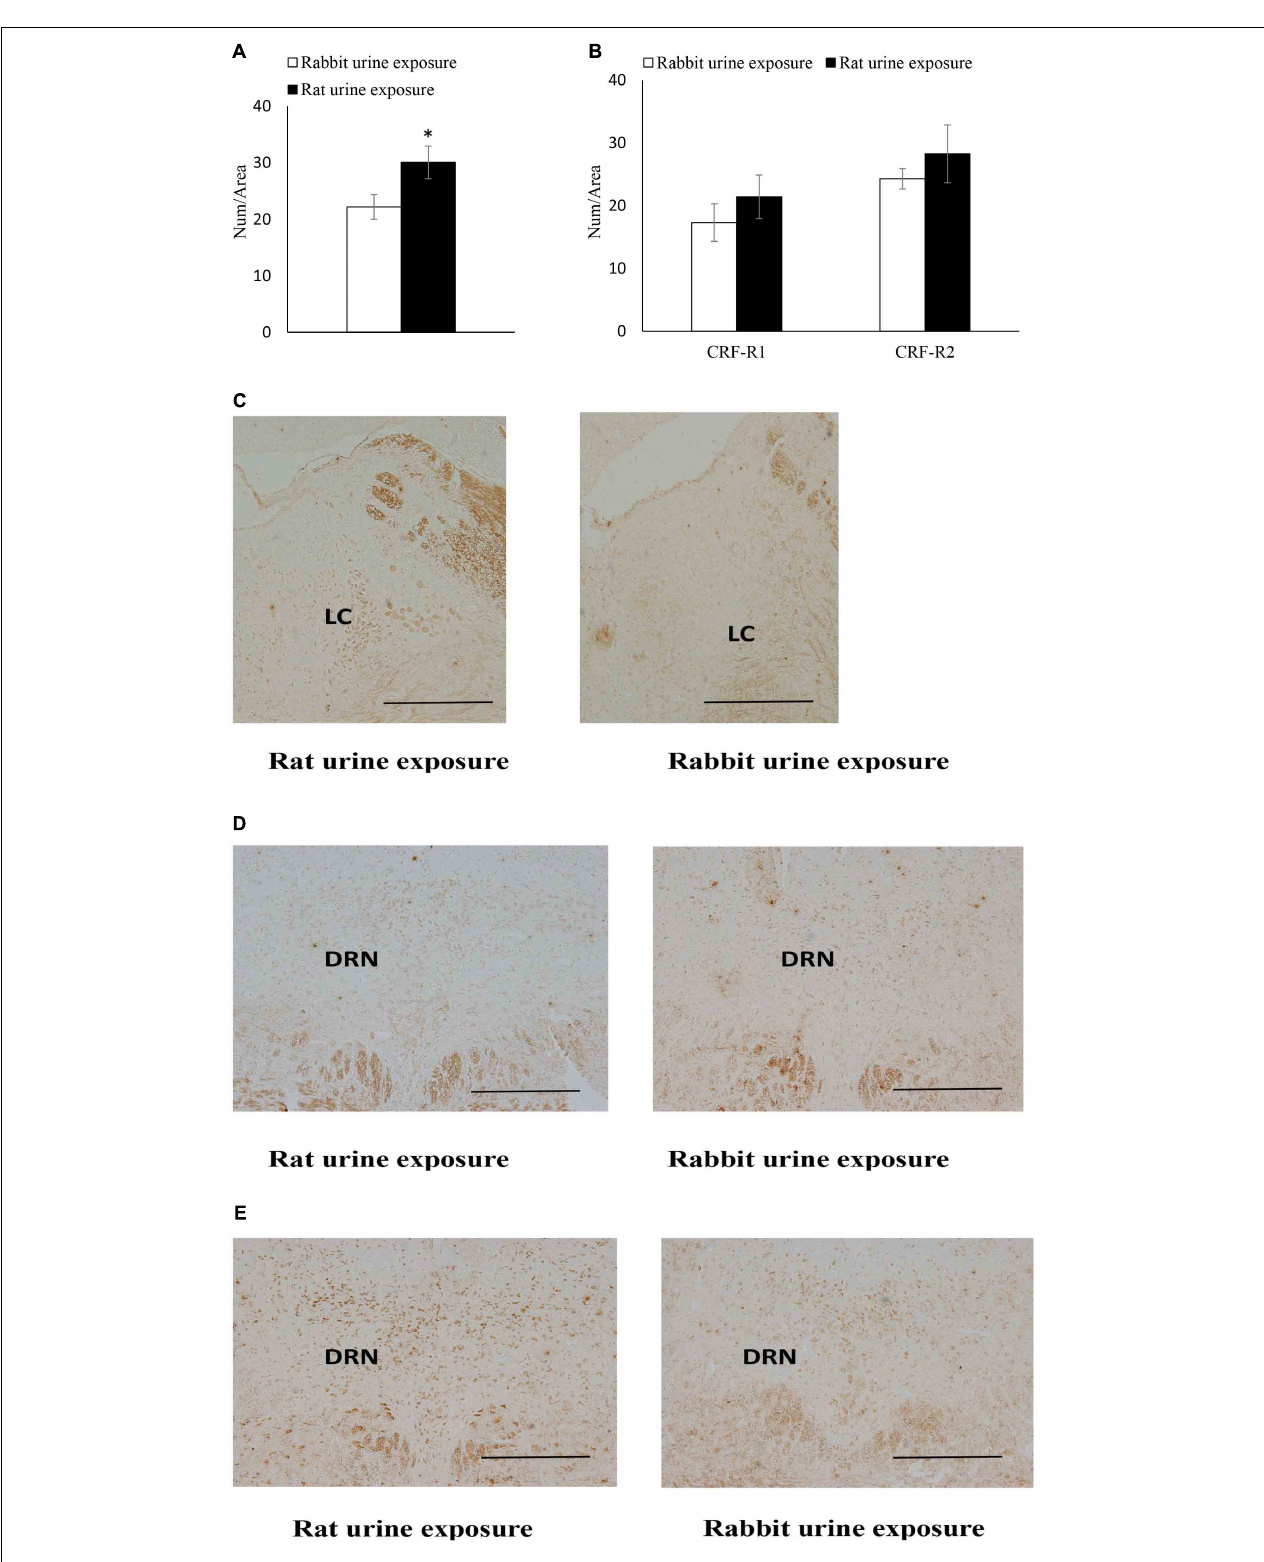
FIGURE 3 | Expression of CRF receptors in rabbit urine exposure group and rat urine exposure group, including CRFR1 expression in locus coeruleus (A) CRFR1, CRFR2 expression in dorsal raphe nucleus (B) , representative immunohistochemistry (IHC) figures of CRFR1 expression in LC (C) CRFR1, (D) CRFR2, and (E) expression in DRN. Data are expressed as the mean ± SEM ( ∗ p < 0.05 compared with the rabbit urine exposure group, Scale bar = 250 µ m).